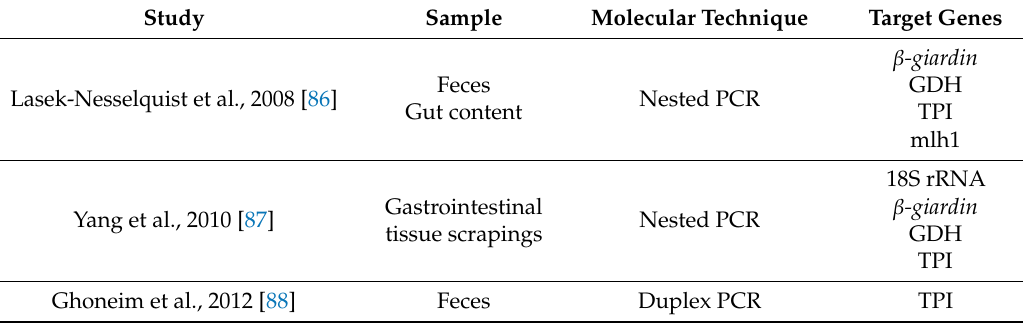
Table 7. Comparative table on the molecular methods (technique and target genes) used for identifying zoonotic Giardia duodenalis assemblages in fish